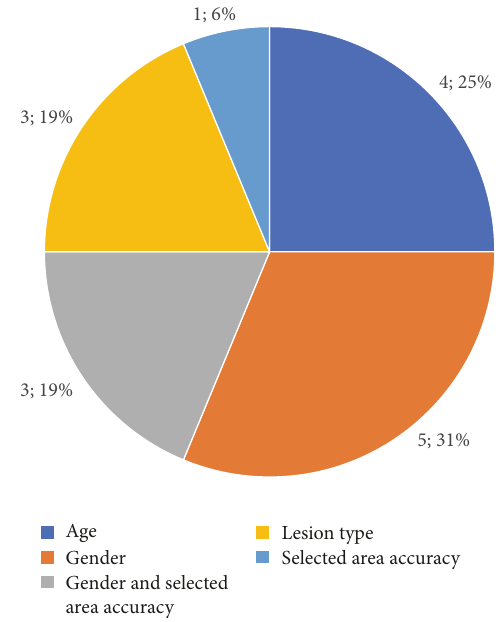
Figure 5: Frequency of referral to previously stated reasons for declaring a query